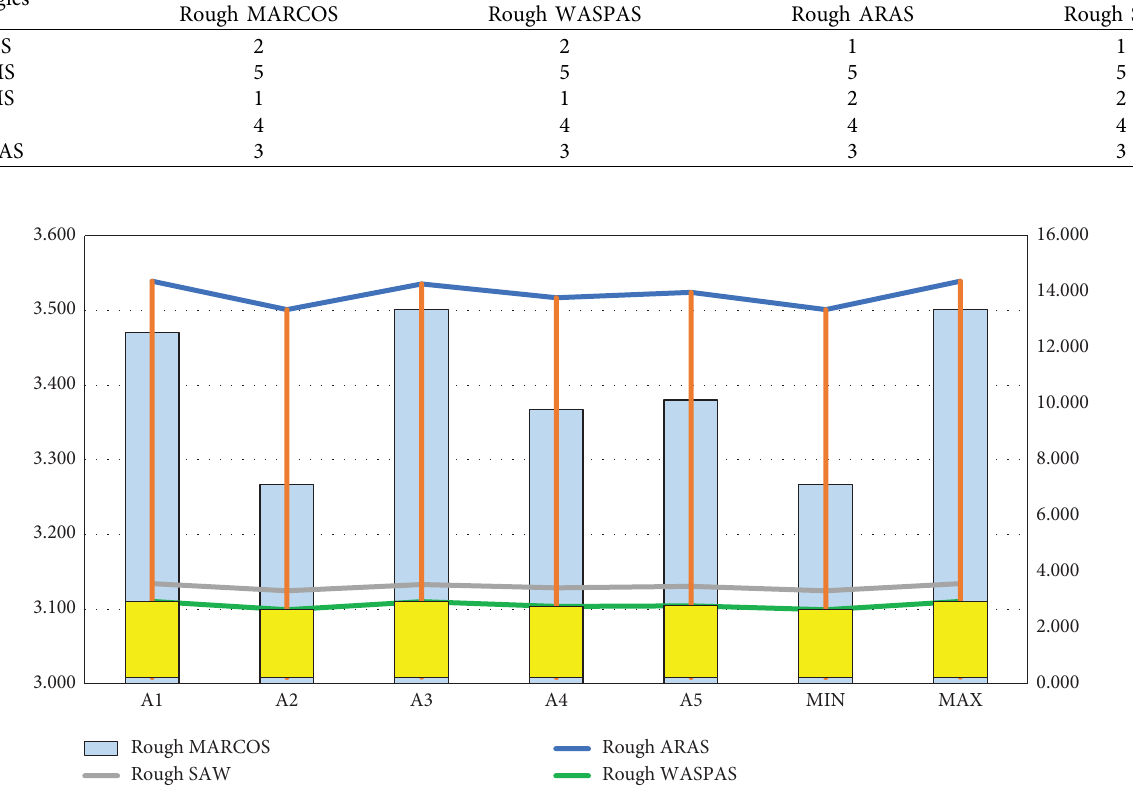
Figure 3: Alternative values in comparative